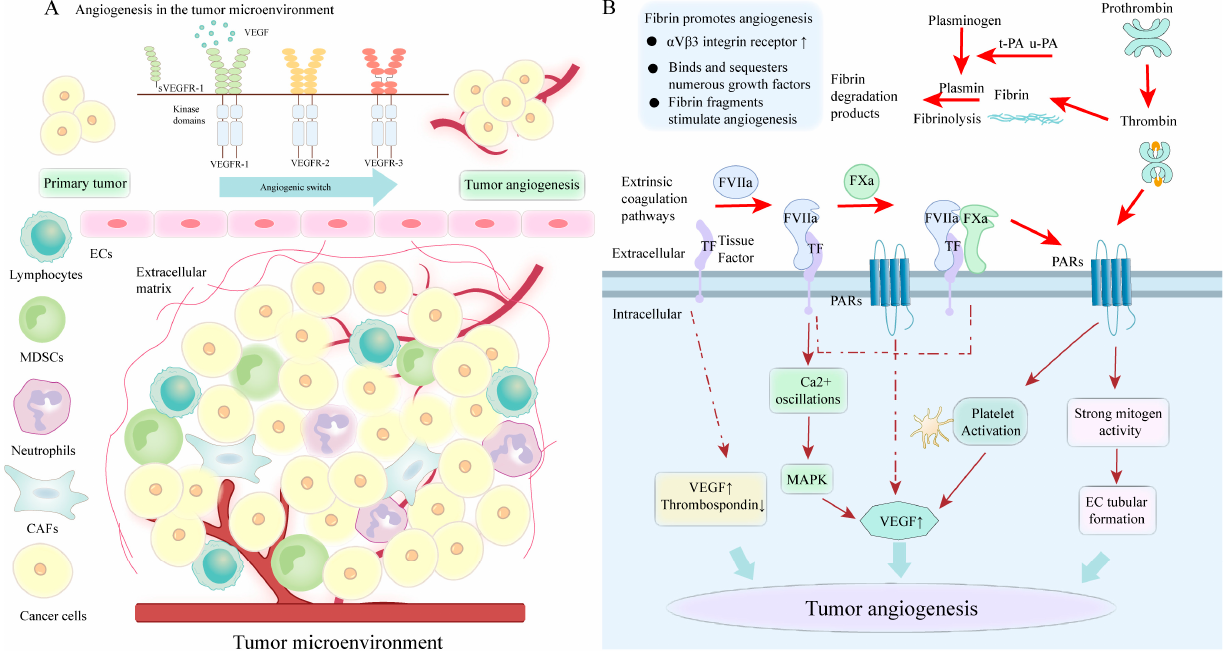
Figure 3. PS-mediated coagulation cascade involved in tumor angiogenesis. ( A ) Angiogenesis in the tumor microenvironment. ( B ) The mechanisms of angiogenesis induced by coagulation factors. TF promotes tumor-directed angiogenesis through upregulating vascular VEGF expression and downregulating the angiogenesis inhibitor (thrombospondin) expression. TF/FVIIa complexes cause Ca2+ oscillations and activate MAPK pathway, resulting in VEGF expression. The TF/FVIIa/FXa complexes activate one or more PARs to support angiogenesis. Thrombin/PAR-1 activation can produce strong mitogen activity on ECs and vascular progenitor cells to induce EC tubular formation in the matrix membrane. Additionally, Thrombin/PAR-1 activated platelets lead to their aggregation and degranulation (VEGF). The fibrin matrix can upregulate the expression of α V β 3 integrin receptor to promote angiogenic responses. The fibrin matrix sequesters and protects numerous growth factors (VEGF) from being degraded by proteinase in ECM. Fibrin fragments (E fragments) are shown to stimulate angiogenesis. VEGF: vascular endothelial growth factor; ECs: endothelial cells; MDSCs: myeloid-derived suppressor cells; CAFs: cancer-associated fibroblasts; t-PA: tissue-type plasminogen activator; u-PA: urokinase-type plasminogen activator; TF: tissue factor; PARs: Protease-activated receptors; MAPK: the mitogen-activated protein kinase; FVIIa: activated factor VII; FXa: activated factor X.